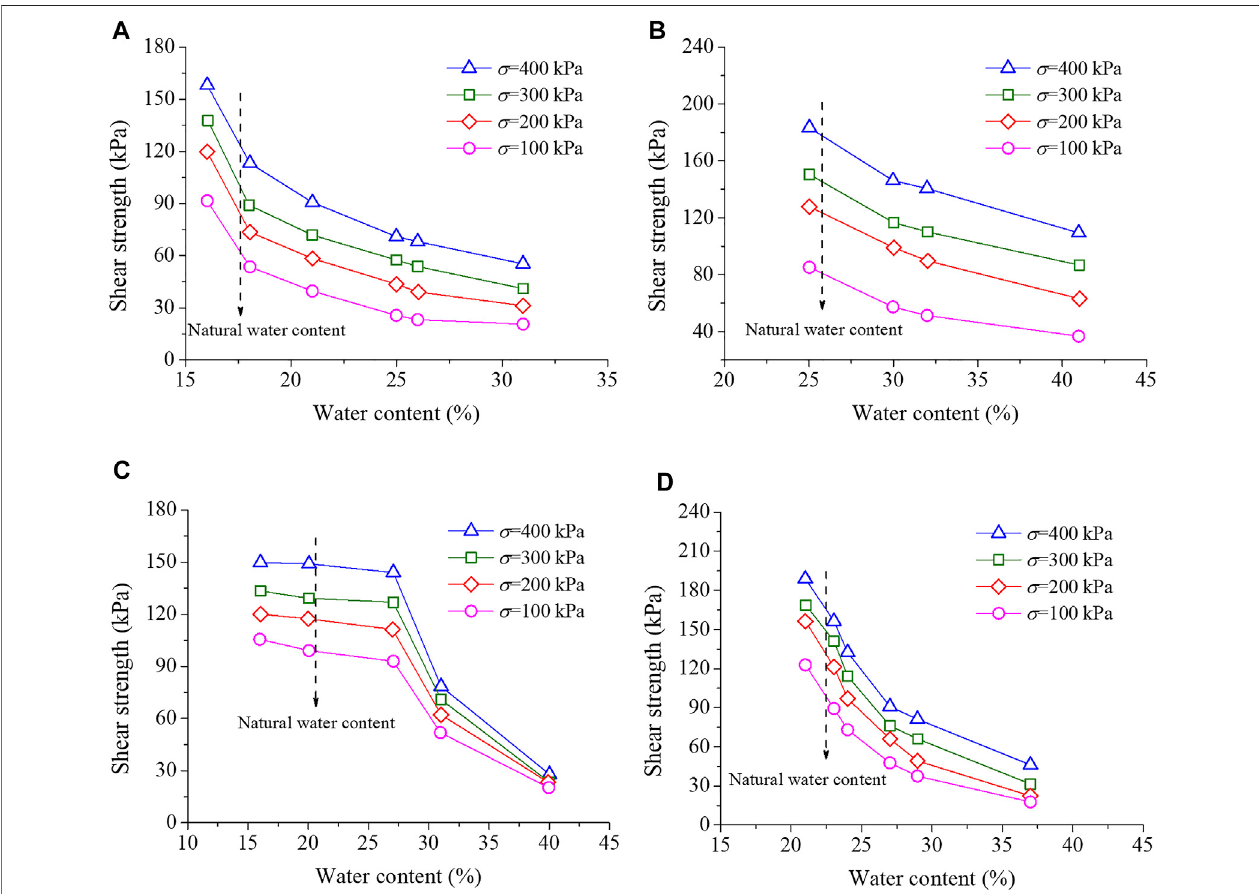
FIGURE 3 | Variations of shear strength with water content for (A) WSC samples; (B) GCS samples; (C) RC-I samples and (D) RC-II samples.